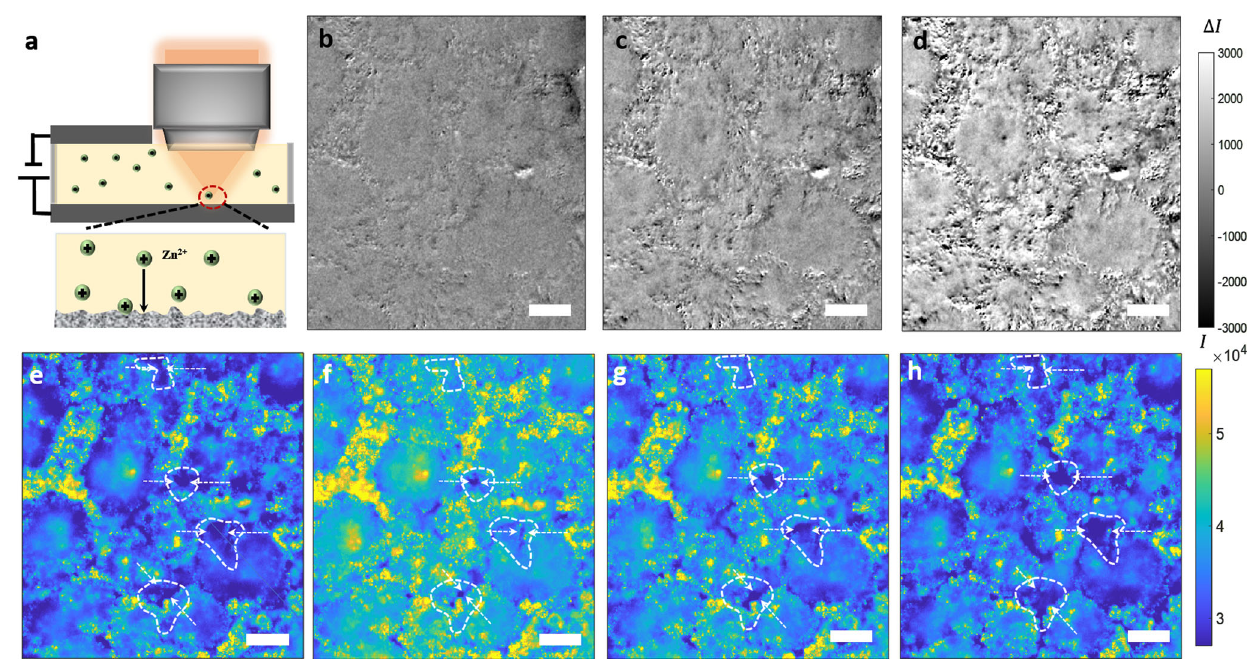
Fig. 3 | In-situ visualization of Zn plating/stripping on Zn-Cu anode. a Experimental setup. b – d The differential images of Zn-Cu anode in the early stages of Zn plating. The images were taken at 5s, 10s, and 20s of Zn plating, and then subtractedfrom the fi rst image. The contrast shows the intensity change( 4 I )